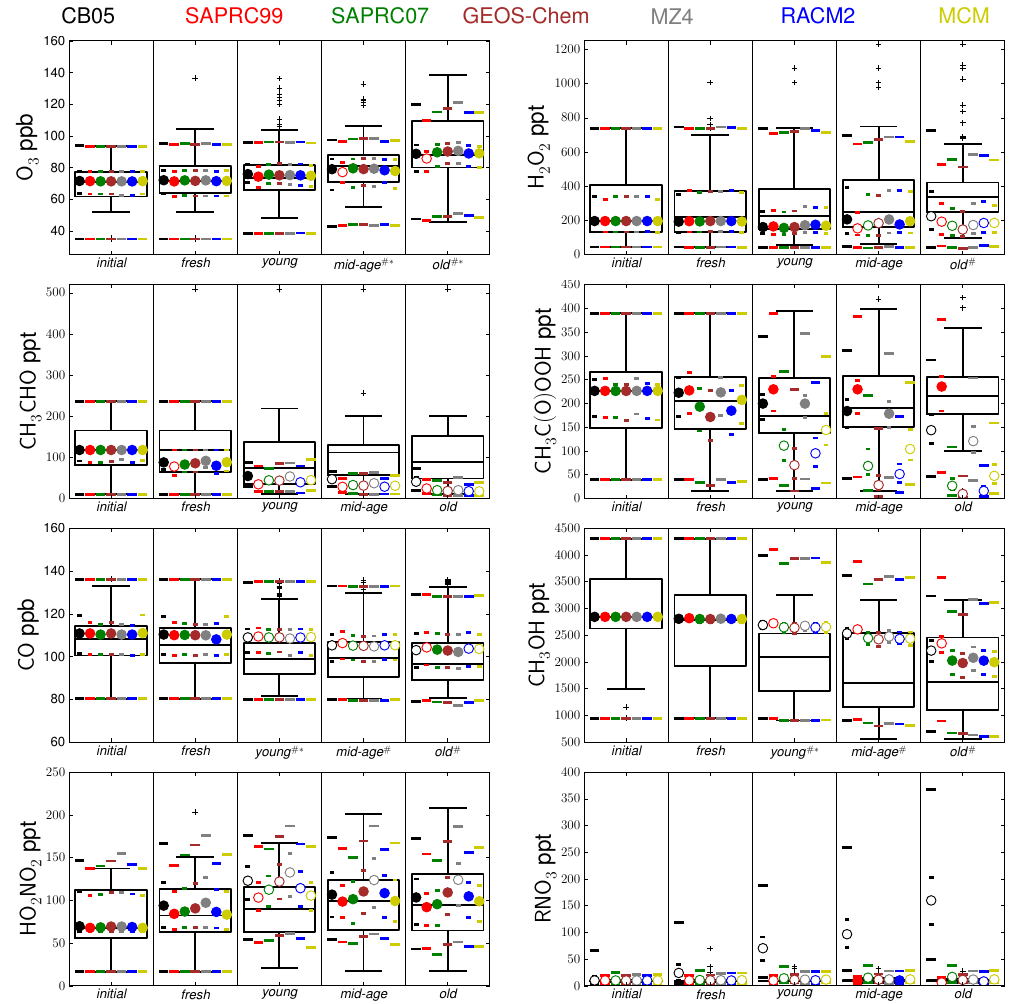
Fig. 5. Simulation results (circle: median; bars: 0, 25, 75, 100 percentiles) and observations (box and whisker) binned by NO x :HNO 3 . For observations, each age category is superscripted for statistical difference ( p < 0 . 0001) from the preceding ( ∗ ) and fresh (#) age group. For model predictions, the median for each chemical mechanism is left hollow when statistically different ( p < 0 . 0001) from the observations.